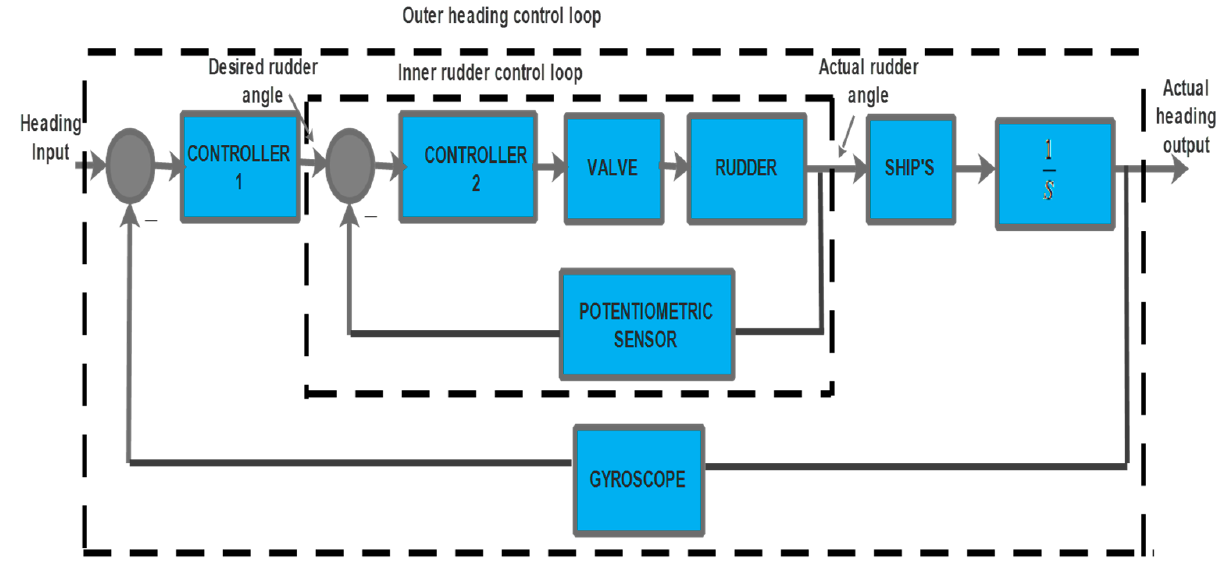
Figure 3. Control loop of heading plane .